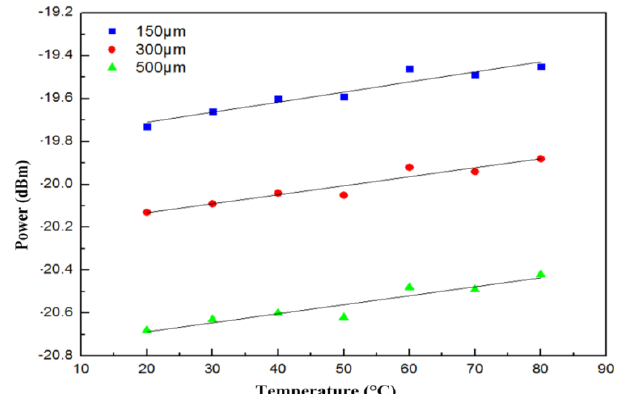
Figure 6. Changes in sensor optical power with displacement maintained at 150 μ m, 300 μ m, and 500 μ m as different temperatures were applied.